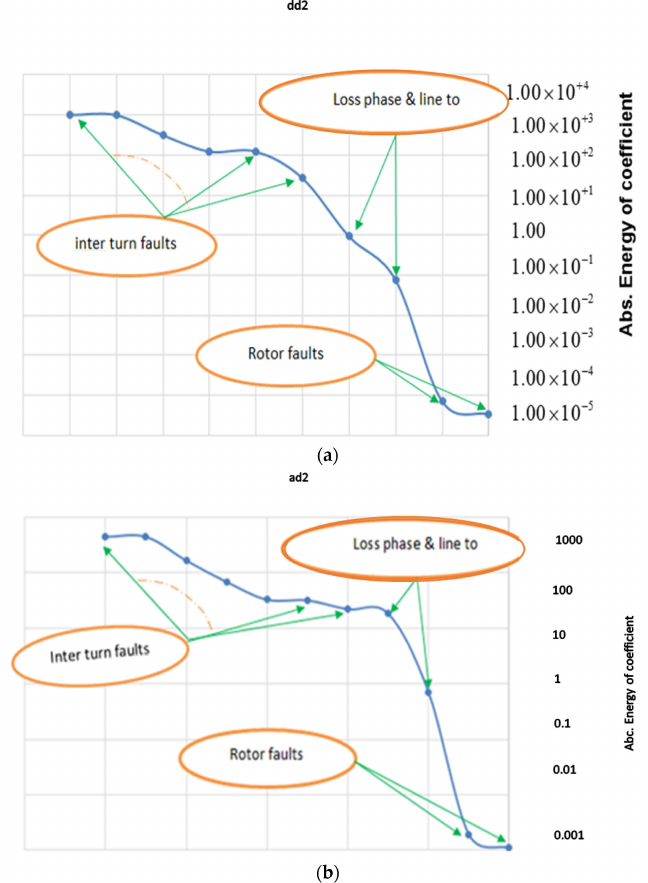
Figure 17. Entropy power energy curve for ( a ) WPT dd2− and ( b ) ad2 subband’s coefficients, where the regions representing different types of faults have been annotated on the curves.